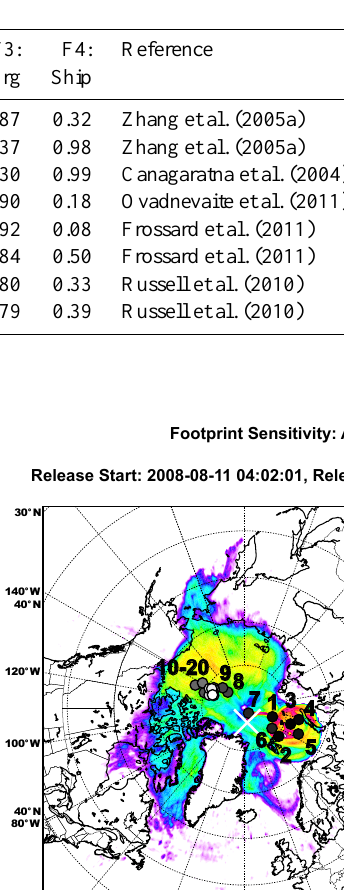
Table 5. Correlation coefficient of factor mass spectra with reference mass spectra.